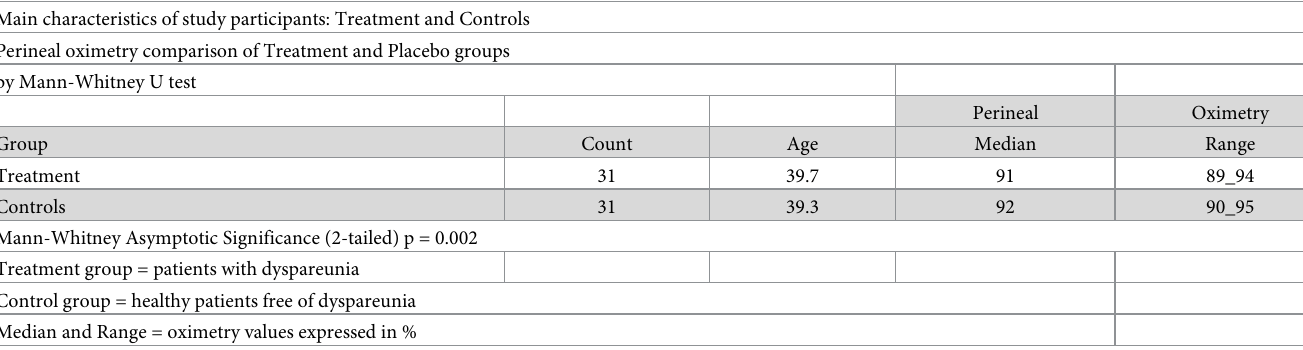
Perineal Oximetry